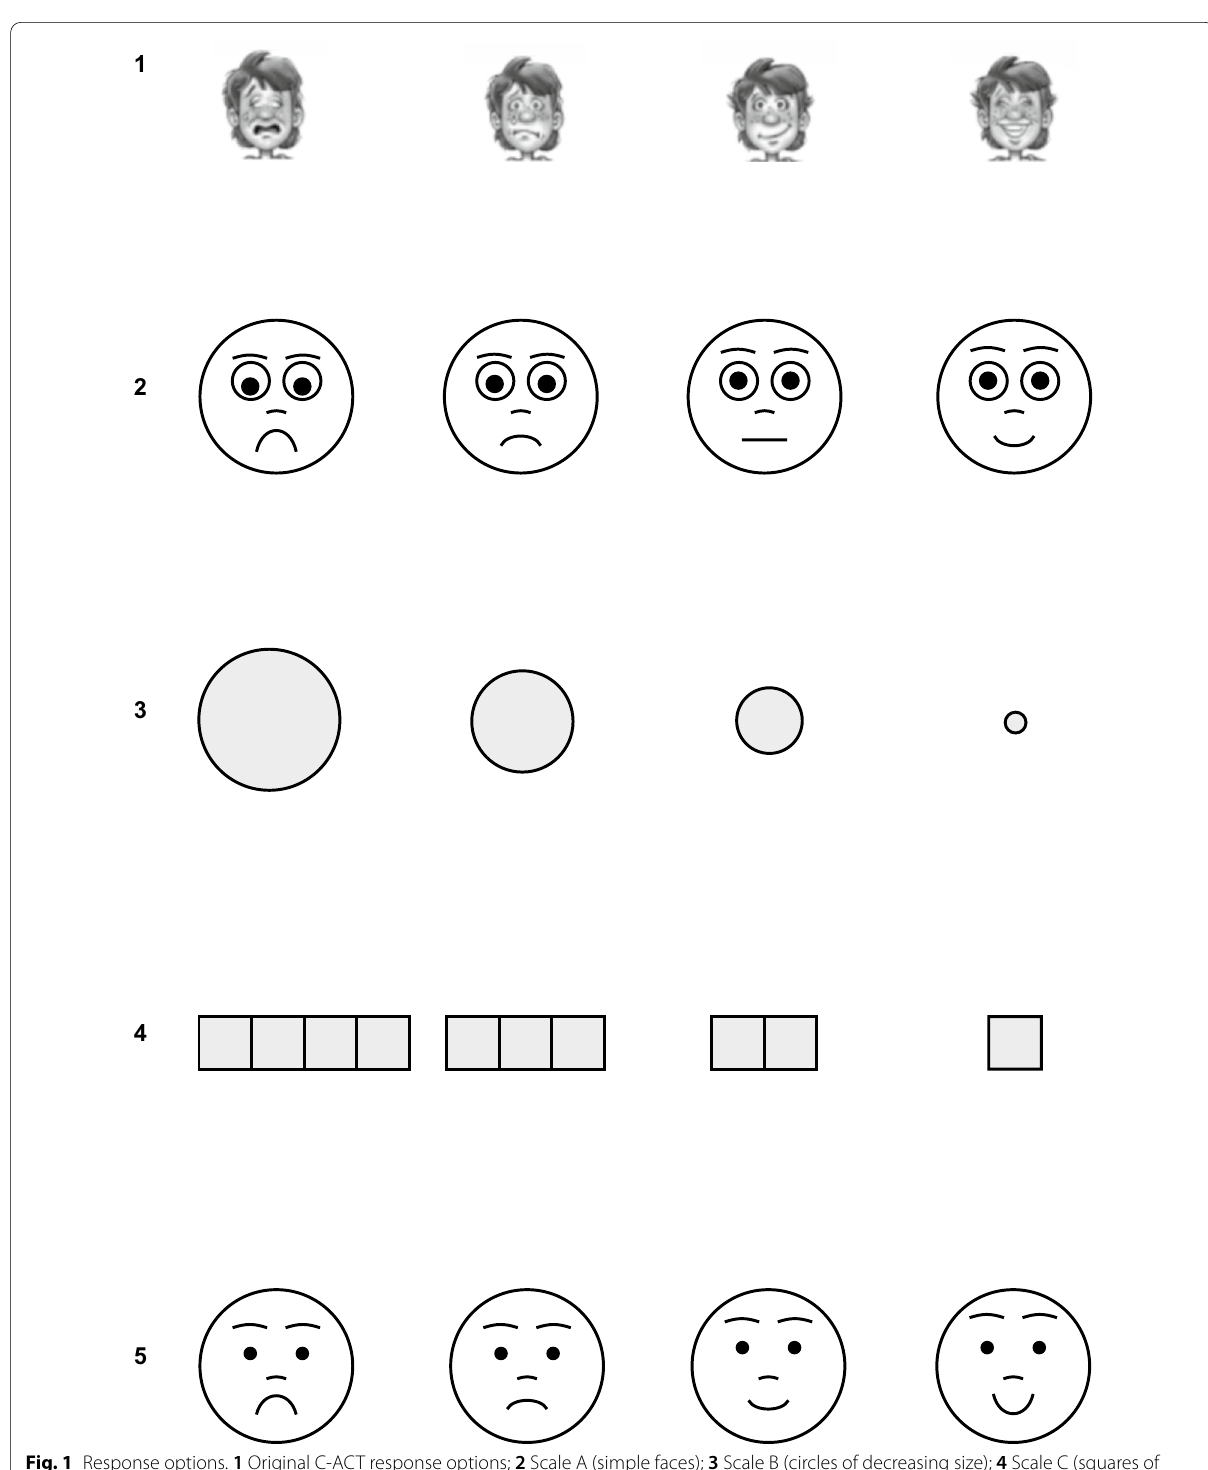
Fig. 1 Response options. 1 Original C‑ACT response options; 2 Scale A (simple faces); 3 Scale B (circles of decreasing size); 4 Scale C (squares of decreasing quantity); 5 Modified Scale A for Stage 2 (simplified faces with modified eyes and mouth), developed after Stage 1 analysis; response options from left to right: option 1 (negative response), option 2 (slight negative response), option 3 (slight positive response), option 4 (positive response). C‑ACT, CHILDHOOD ASTHMA CONTROL